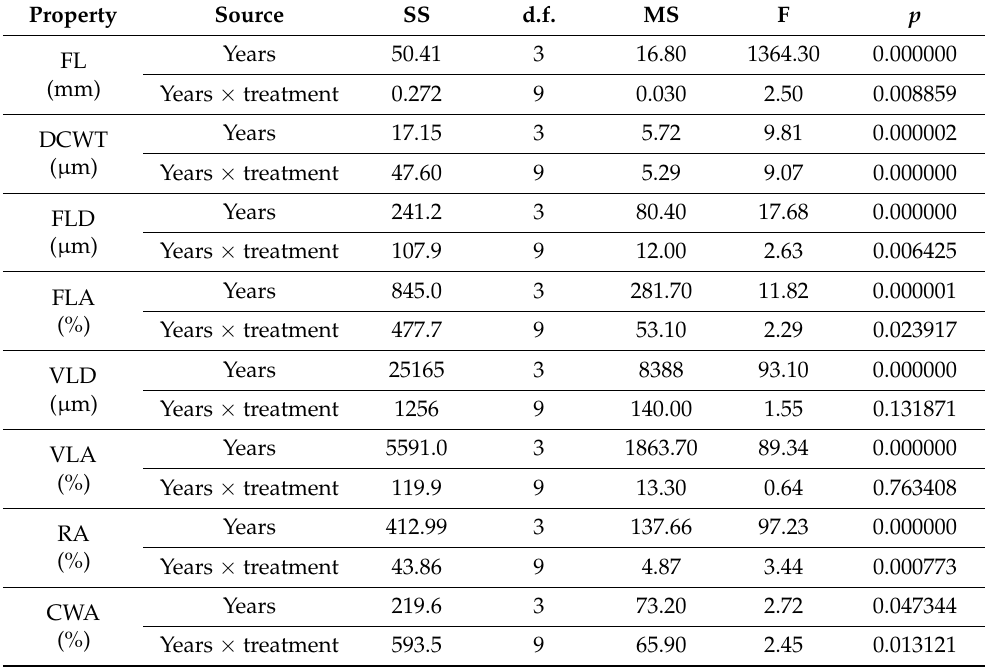
Table 2. Results of repeated measures analysis of variance ANOVA for the anatomical properties of the juvenile wood of the clone ‘Villafranca’ in different years and treatments by year. Property Source SS